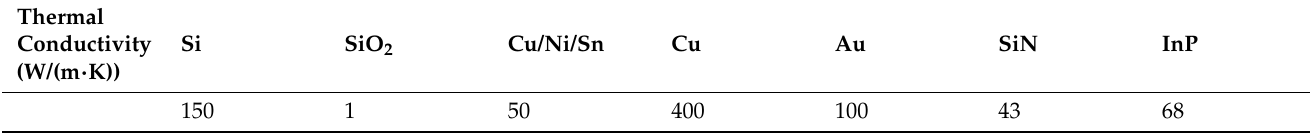
Table 2. Overview of material properties used for simulation. Cu/Ni/Sn was used for the solder bump metallisation, and Au p- and n-contacts on the